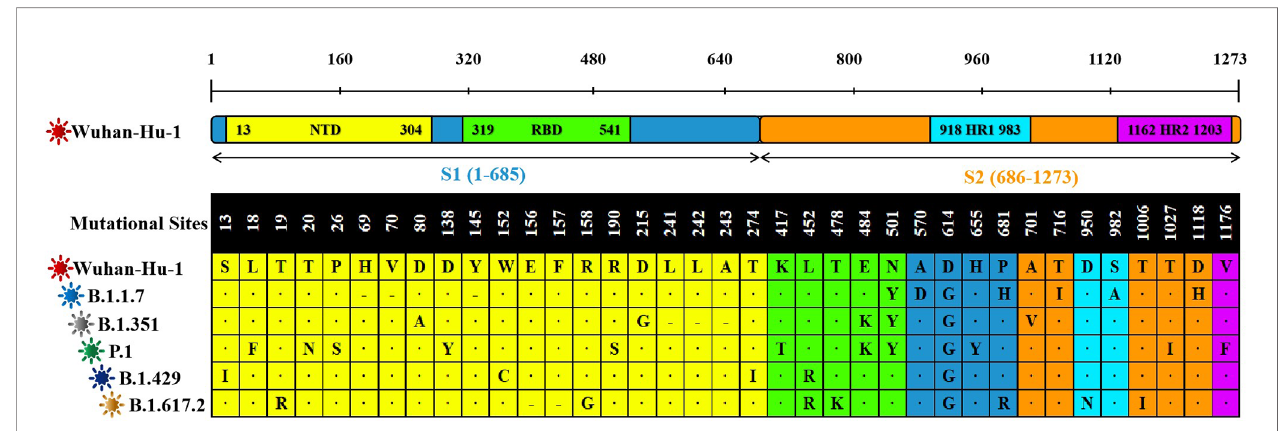
FIGURE 2 | The sequence alignment of S proteins in different virus strains. The study had screened S proteins of six kinds of different SARS-CoV-2 virus strains. The Wuhan-Hu-1 strain was selected as the reference sequence in the sequence alignment. In this fi gure, we had used different colors to represent the different domains of the S protein. From the N-terminal to the C-terminal of the S protein, a total of 37 amino acid positions had been changed. Among these variations, “ · ” was omission, which represented the same amino acid as the reference sequence. “ - ” was loss, which represented the deletion of amino acid sequence. And the remaining mutation sites were amino acid missense mutation.